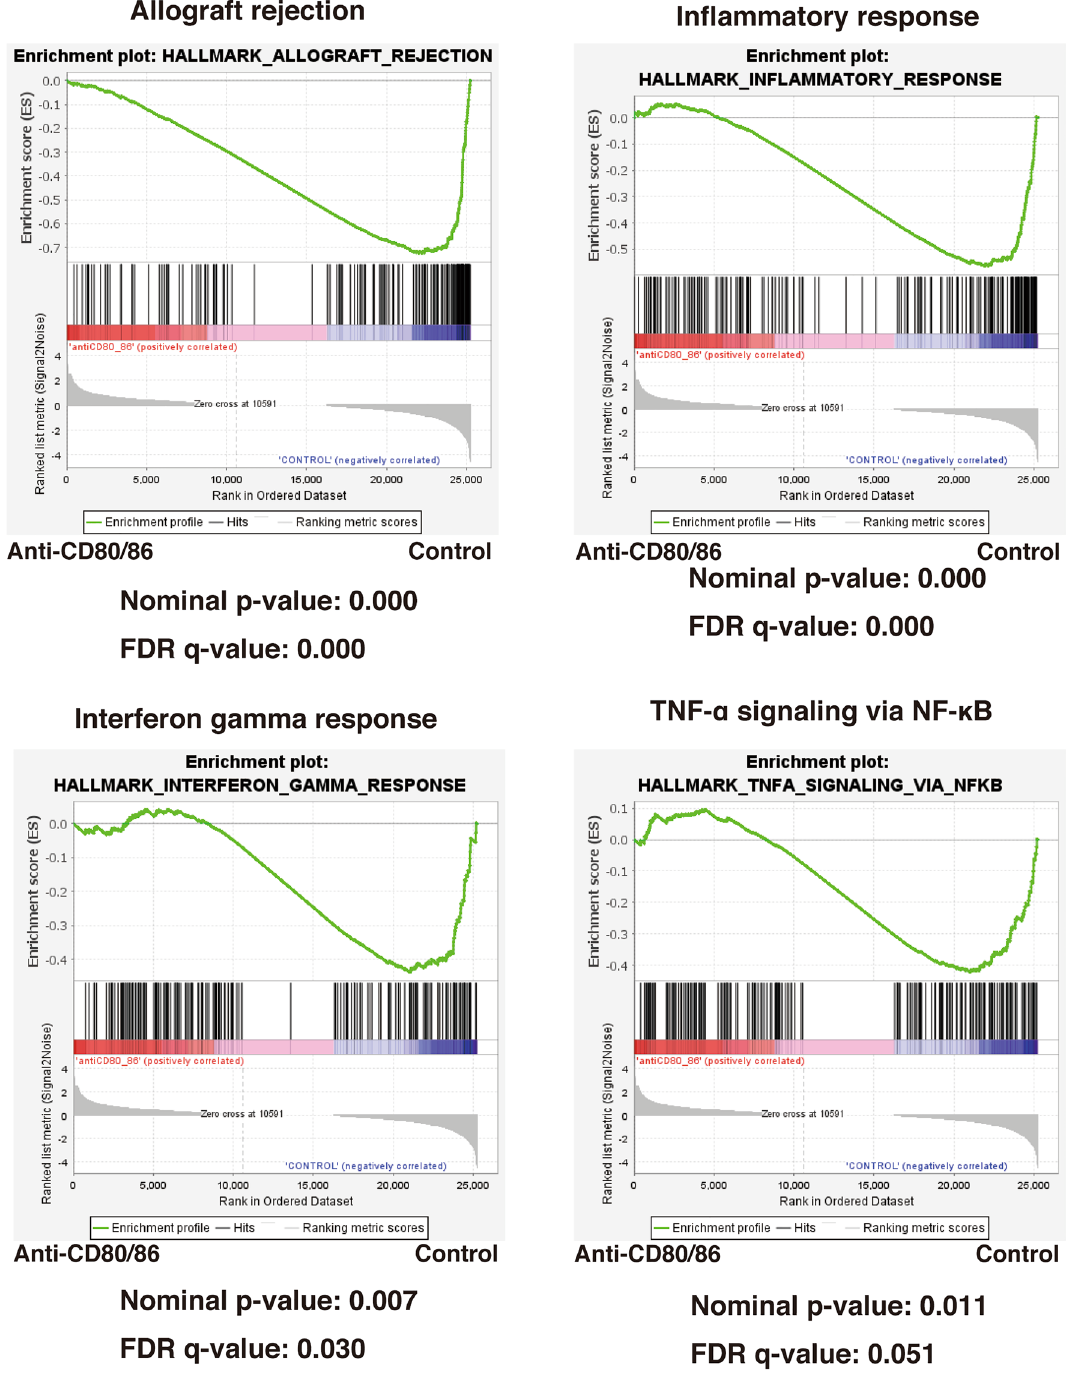
Figure 7. Gene set enrichment analysis (GSEA) of signaling pathways in high-risk corneal grafts between the anti-CD80/86 antibody injection and phosphate-buffered saline injection groups. GSEA querying hallmark genes (h.all.v6.0.symbols.gmt) depicting significant enrichment of Allograft Rejection genes (HALLMARK_ ALLOGRAFT_REJECTION), Inflammatory response genes (HALLMARK_INFLAMMATORY_GENES), Interferon gamma response genes (HALLMARK_INTERFERON GAMMA RESPONSE), and TNF-α signaling via NFKB (HALLMARK_TNFA_SIGNALING_VIA_NFKB). FDR false discovery